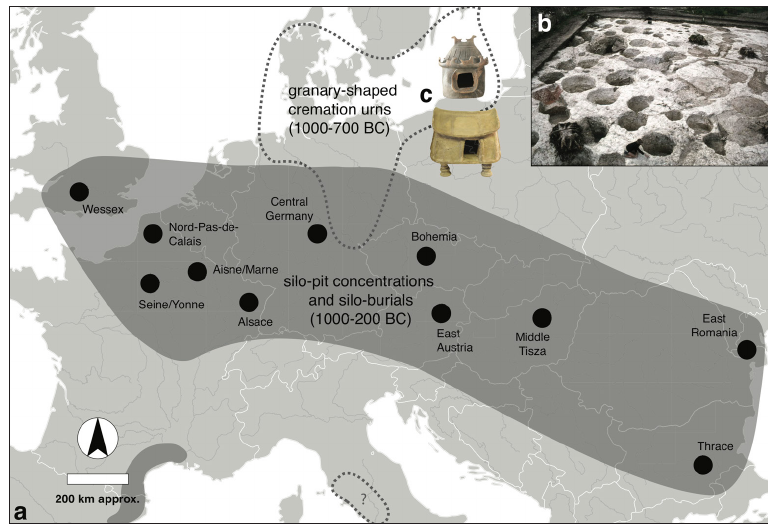
Figure 1: Silo-pits and post-granaries: (a) a band across temperate Europe of silo-pit concentrations and re-used silo-pits with burials, along with a northern distribution of Late Bronze Age ‘house’ urns that probably imitate granaries (selected sources are: Ailinc ă i 2015; Bradley 2002; Delattre et al. 2000; Garcia 1997; Griebl et al. 2017; Király et al. 2013; Landolt et al. 2010; Le Brun Ricalens 2014; Unger and Pecinovská 2015; Van Oyen 2019), (b) a concentration of silo-pits inside the hillfort at Danebury, UK (courtesy of Institute of Archaeology, Oxford University), and (c) two examples of ‘house’ urns from Saxony-Anhalt and Pomerania (Sabatini 2007: pls. 45.1, 42.6, with permission). Note that silo-pits are certainly also found south of the shaded area (e.g. in the Mediterranean Europe), but not in the same concentrations in this period (Figure: A. Bevan, with image permissions as